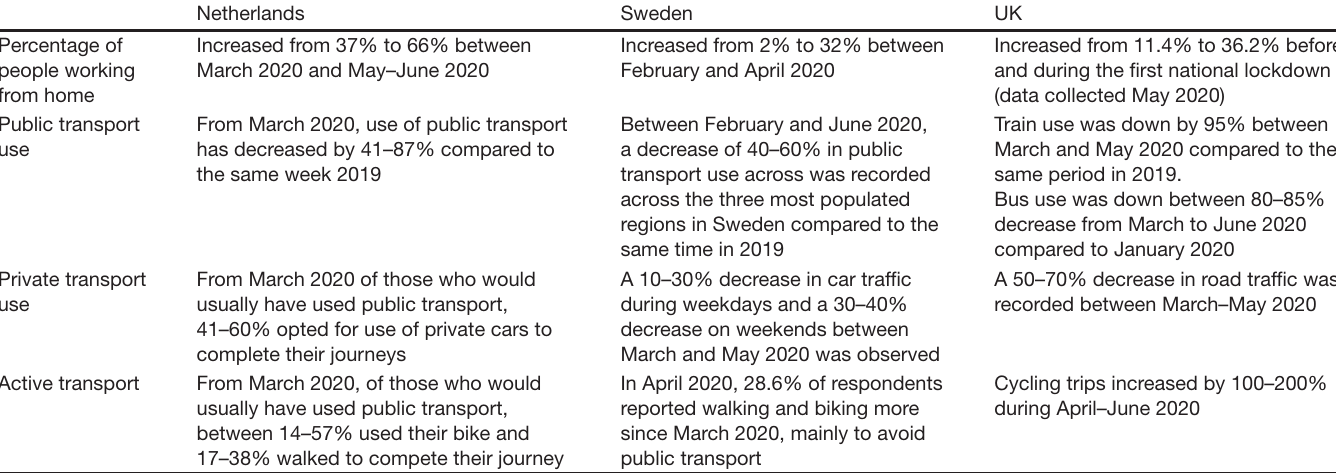
Table 1. Summary of main changes recorded across the Netherlands, Sweden and the UK during COVID-19